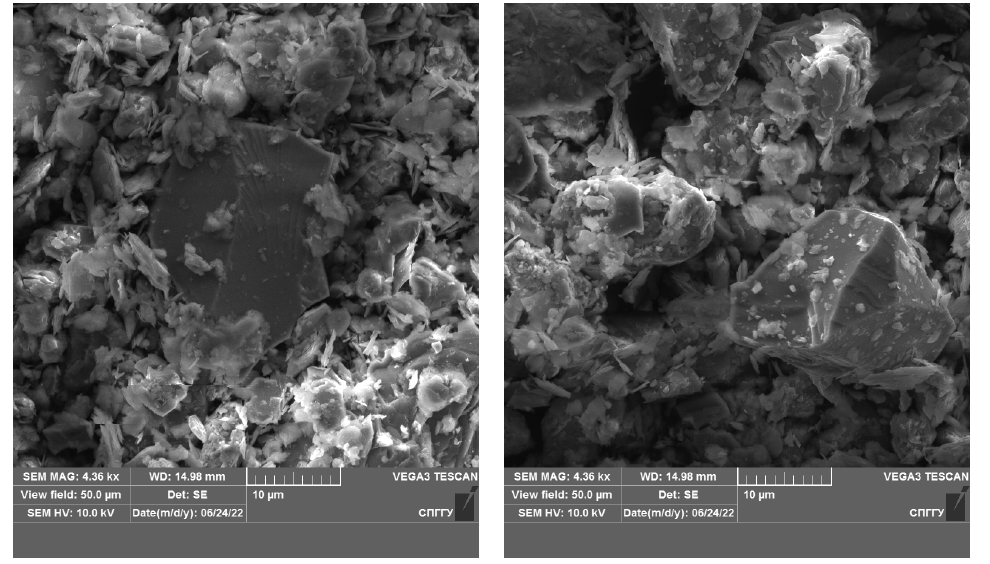
Figure 12. Microphotograph of DOS sample.